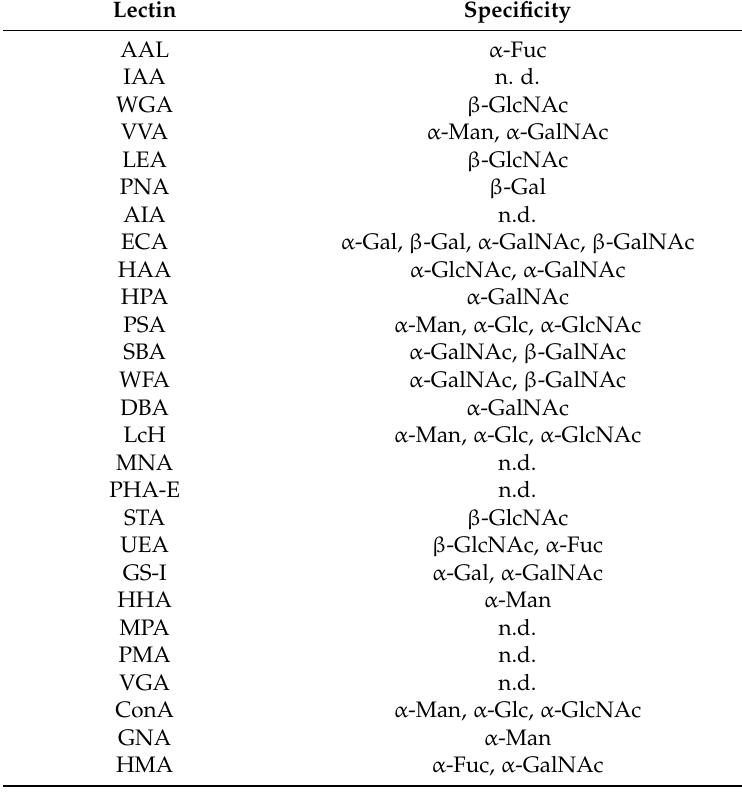
Table 2. Shortlist of lectins that bound most often to the species used in this study. The lectins are listed in the order of binding frequency. Lectin